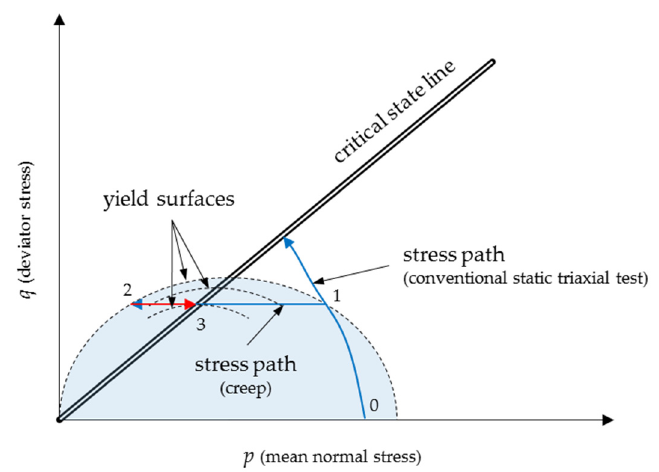
Figure 1. The undrained static creep failure in the scope of the critical state concept.